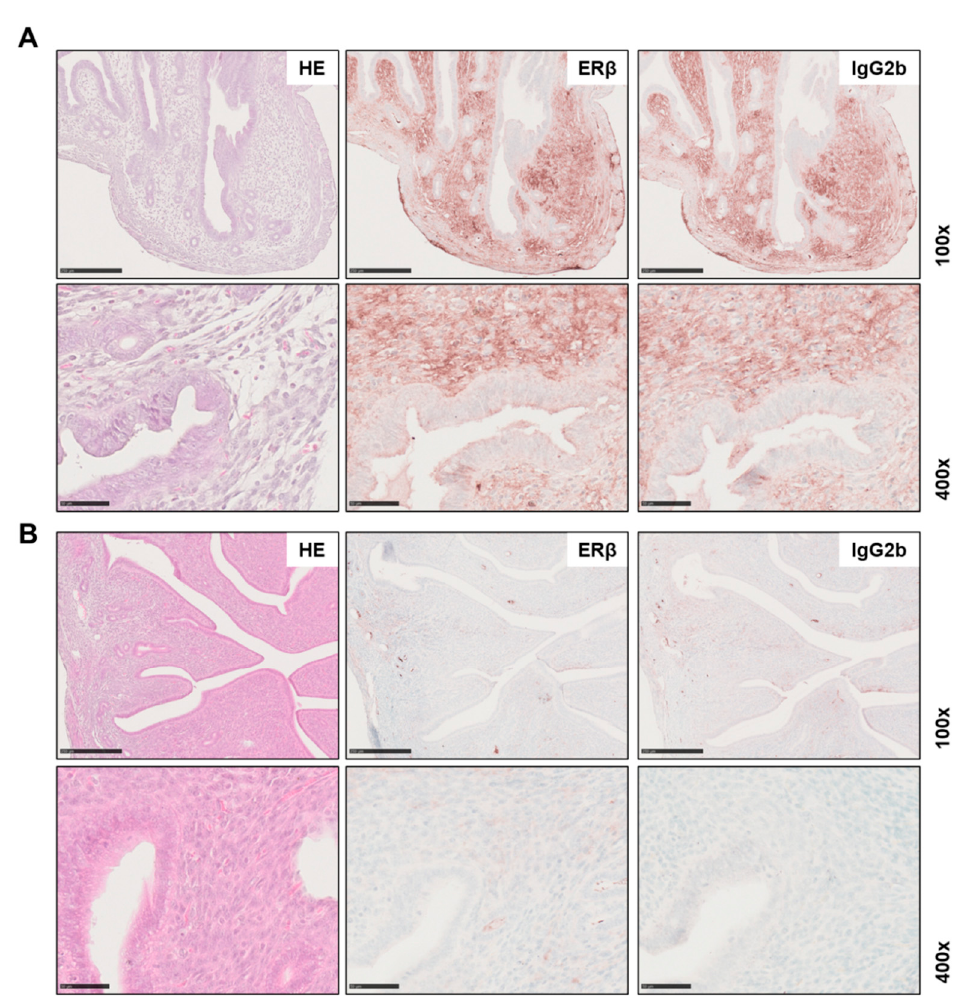
Figure 5. Non-specific background signal in uterine tissue. Tissue slices were prepared as de- scribed in Material and Methods for routine HE stains or immunohistochemical detection of estrogen receptor beta (ER β ) using PPZ0506 or IgG 2b isotope control. Uterine tissue form mice in ( A ) the proestrus and ( B ) the metestrus stage of the estrous cycle are shown. Please note that there are strong differences in non-specific background staining intensity between the different stages. Scale bar 250 µm (100×) or 50 µm (400×).